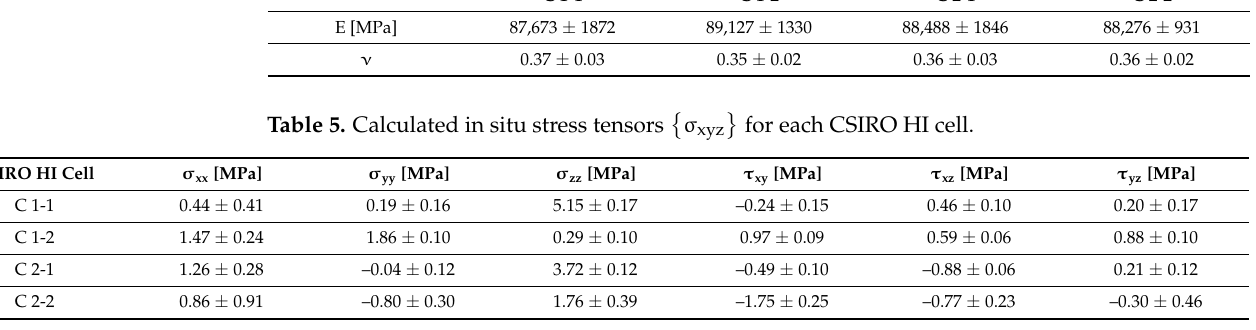
Table 4. Elastic parameters derived from biaxial compression tests. Here, E = Young’s modulus, ν = Poisson’s ratio, C n-n = CSIRO HI cell at different depth.